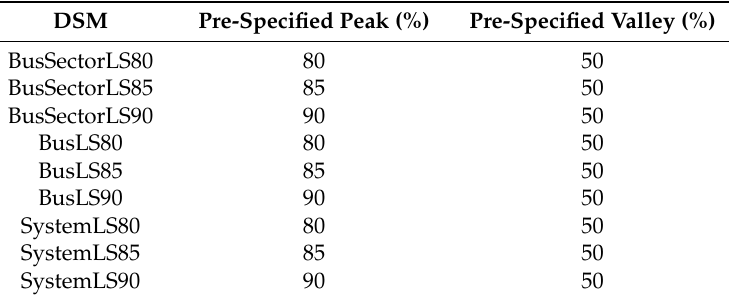
Table 2. Various load shifting initiatives of the DSM.